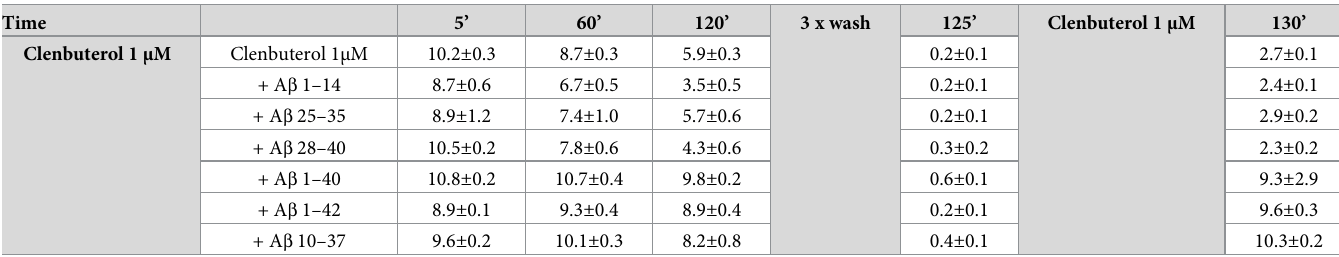
Table 1. Influence of short and long chain Amyloid β peptides on the clenbuterol induced β 2-adrenoceptor desensitization. Time